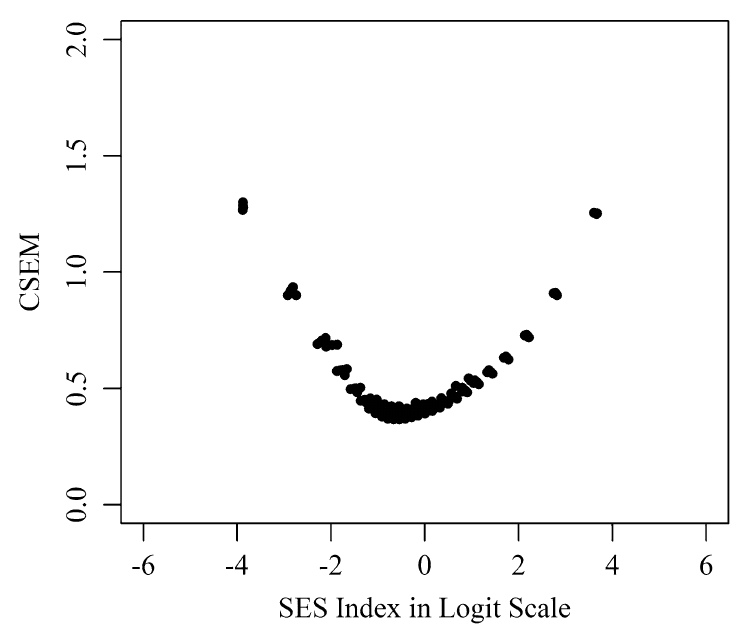
Fig. 8 SES Index and the CSEM for All SACMEQ III education systems